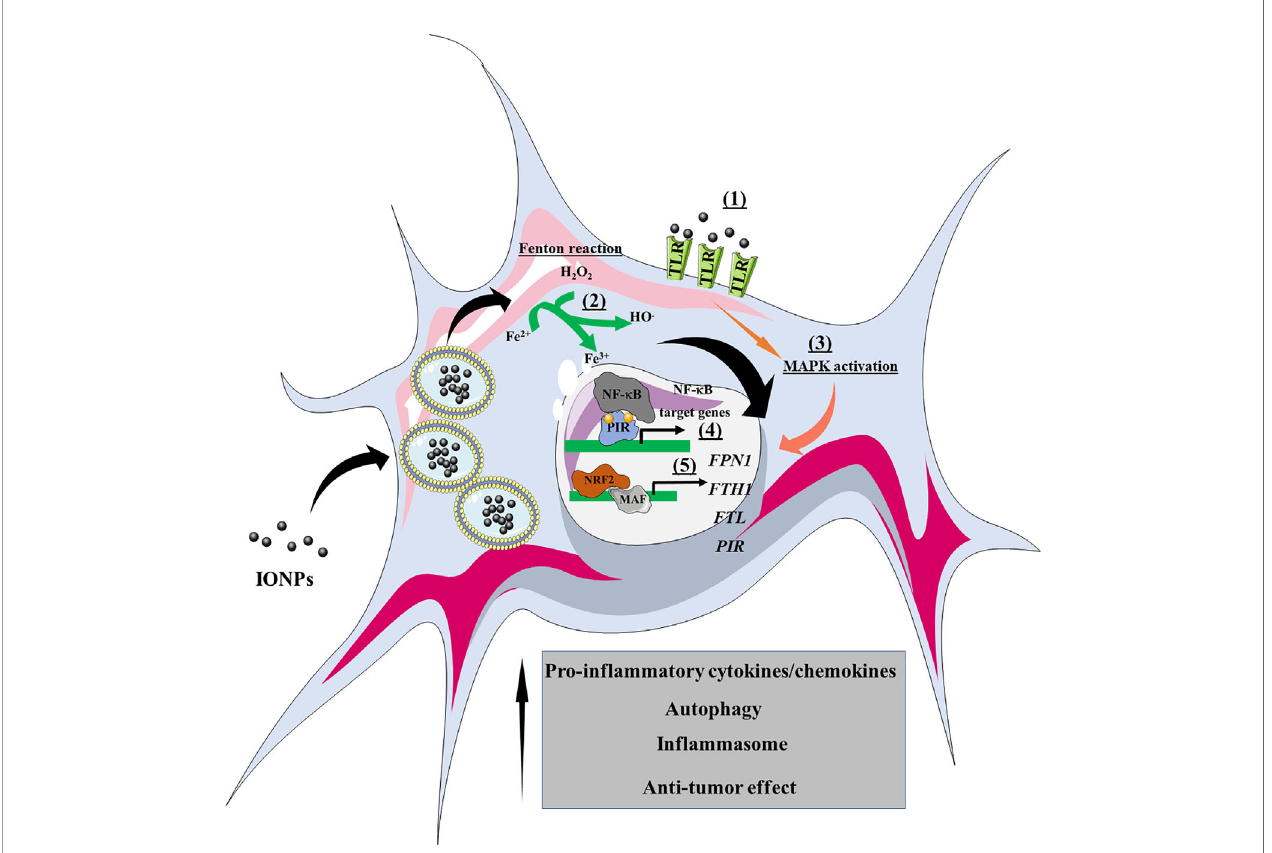
FIGURE 4 | Overview of the effects of IONPs on macrophage polarization. The IONPs can interact with cell surface receptors such as TLRs (1), leading to activation of the MAPK signaling pathway. Once internalized by macrophages, the IONPs are enclosed within endolysosomes where they are biodegraded. Consequently, atomic iron is released into the cytoplasm, where it engages the Fenton reaction and produces ROS (2). As a result, transcriptional reprogramming is triggered, such as that involving NF- k B (e.g., cytokines, chemokines) and NRF2 target genes (e.g., iron metabolism). NRF2, nuclear factor (erythroid-derived 2)-like 2; PIR, Pirin; FPN1 , ferroportin-1 ; FTH1 , ferritin heavy chain; FTL , ferritin light chain; MAPK, mitogen-activated protein kinases; MAF, musculoaponeurotic fi